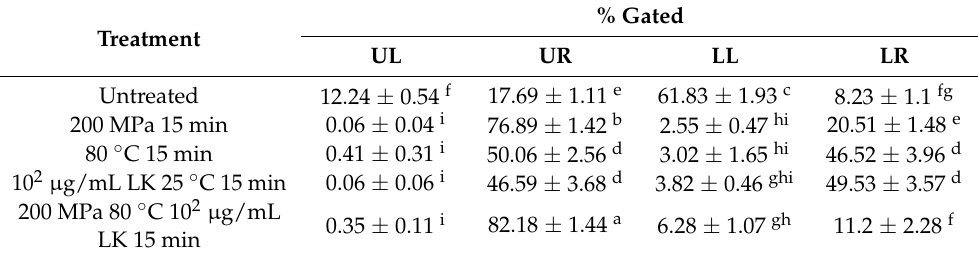
Figure 4. Flow cytometer density plot diagrams of ( A ) untreated spores and spores treated with ( B ) 200 MPa for 15 min, ( C ) 80 ◦ C for 15 min, ( D ) LK at 25 ◦ C for 15 min, and ( E ) 200 MPa at 80 ◦ C combined with LK for 15 min. The concentration of LK was 10 2 µ g/mL. Table 1. Percentage of inactivated spores with different percentage gating in FCM density